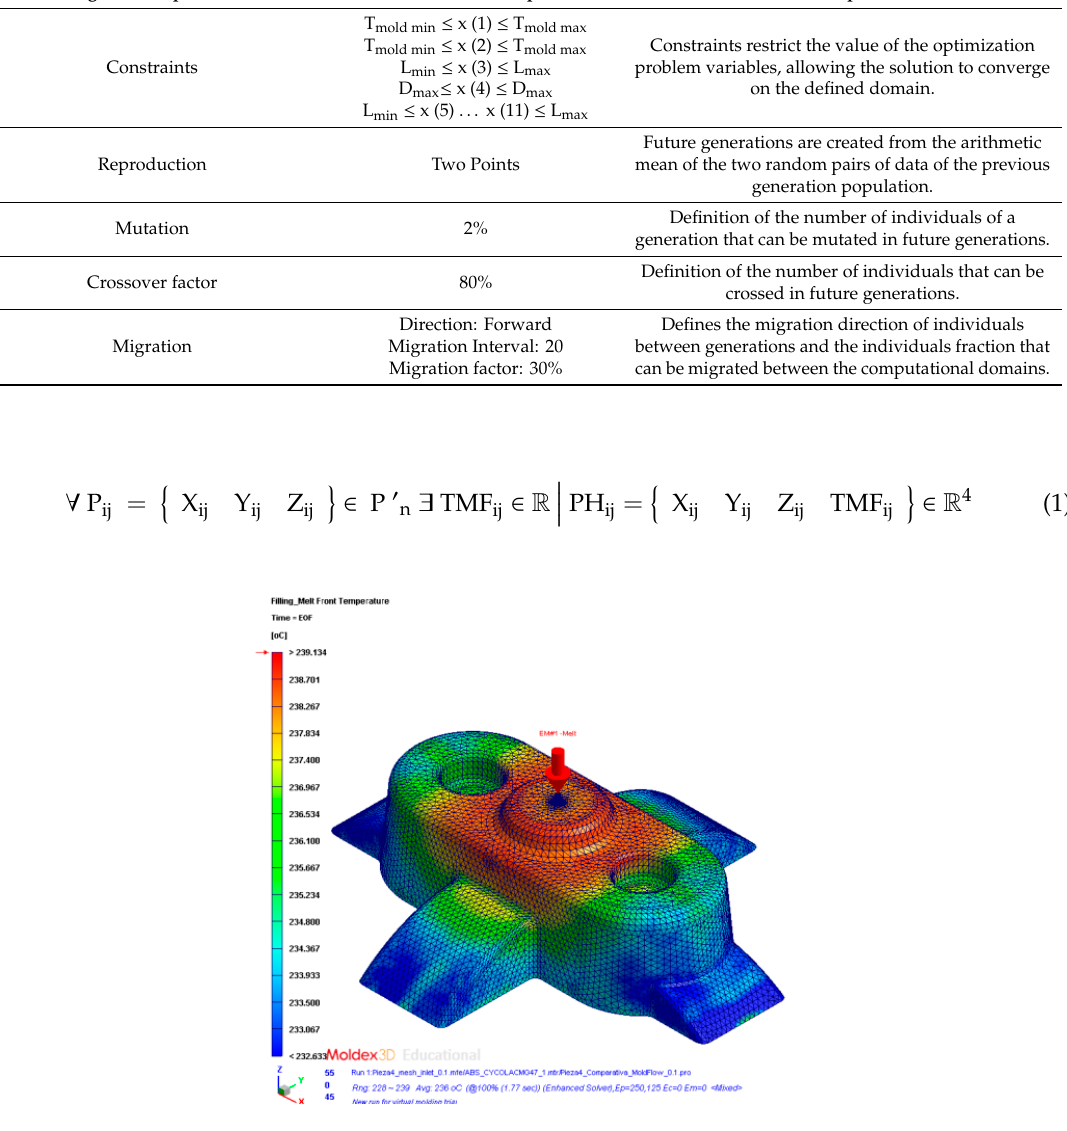
Figure 5. Temperature definition of the melting front during the filling phase of the plastic part.